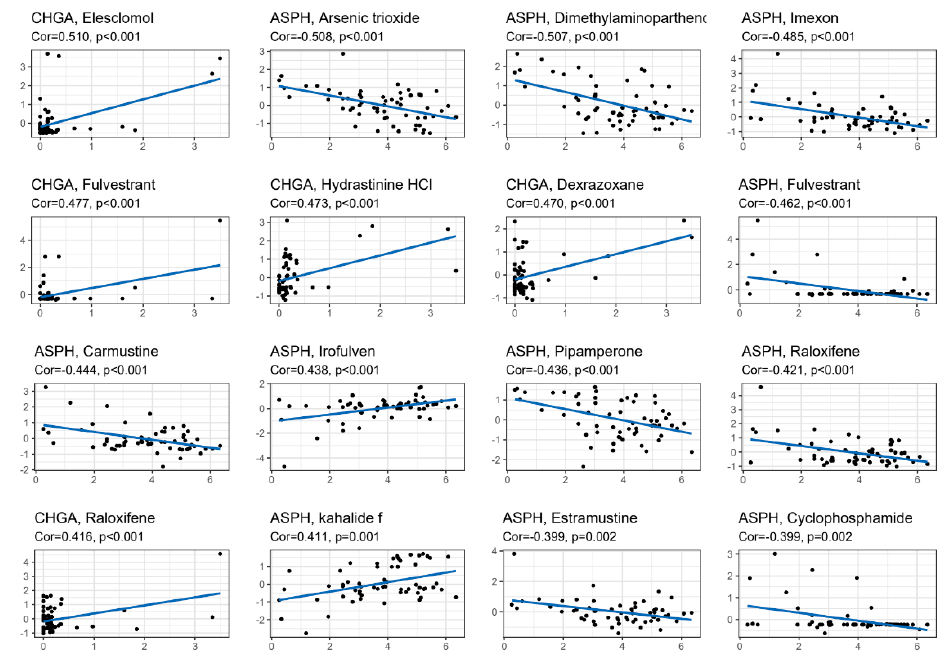
Figure 8. The target gene-drug network analysis was sorted according to the correlation score.